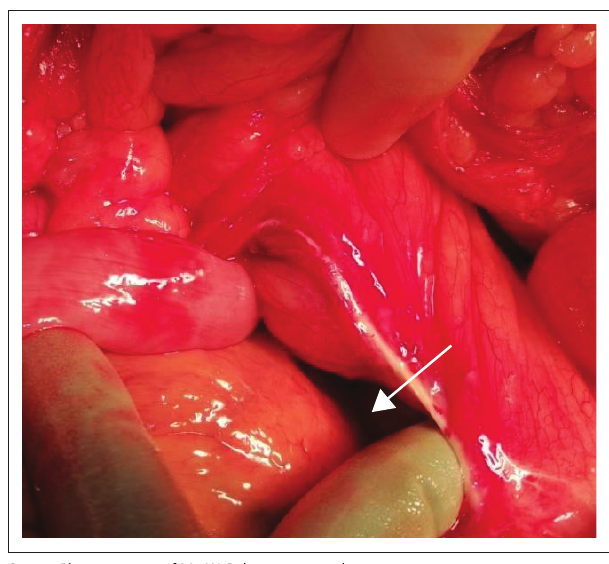
Source : Photo courtesy of Mr. W. Rahaman, general surgeon. FIGURE 4 : Intraoperative findings demonstrating the congenital defect, fossa of Landzert and the left paraduodenal hernia.